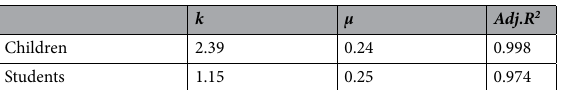
Table 6. Fitting results of the distribution of relaxation time of children and